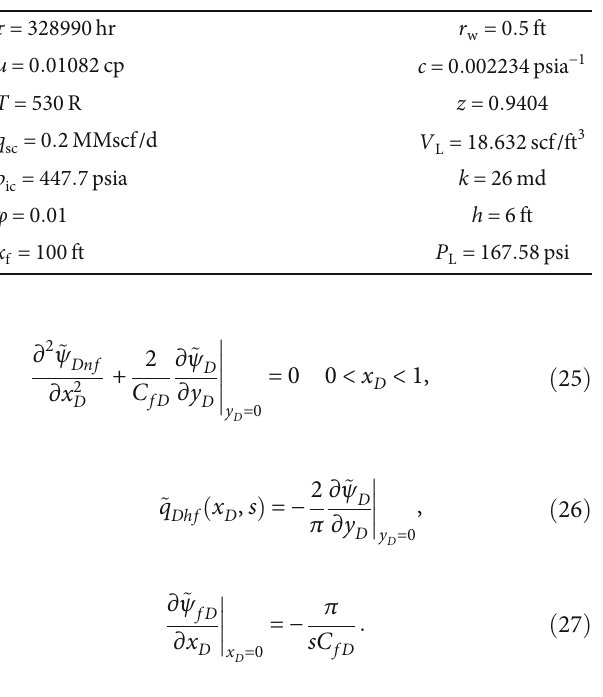
Figure 8: The Duhamel convolution is used to obtain production rate. Table 1: The basic data to verify the